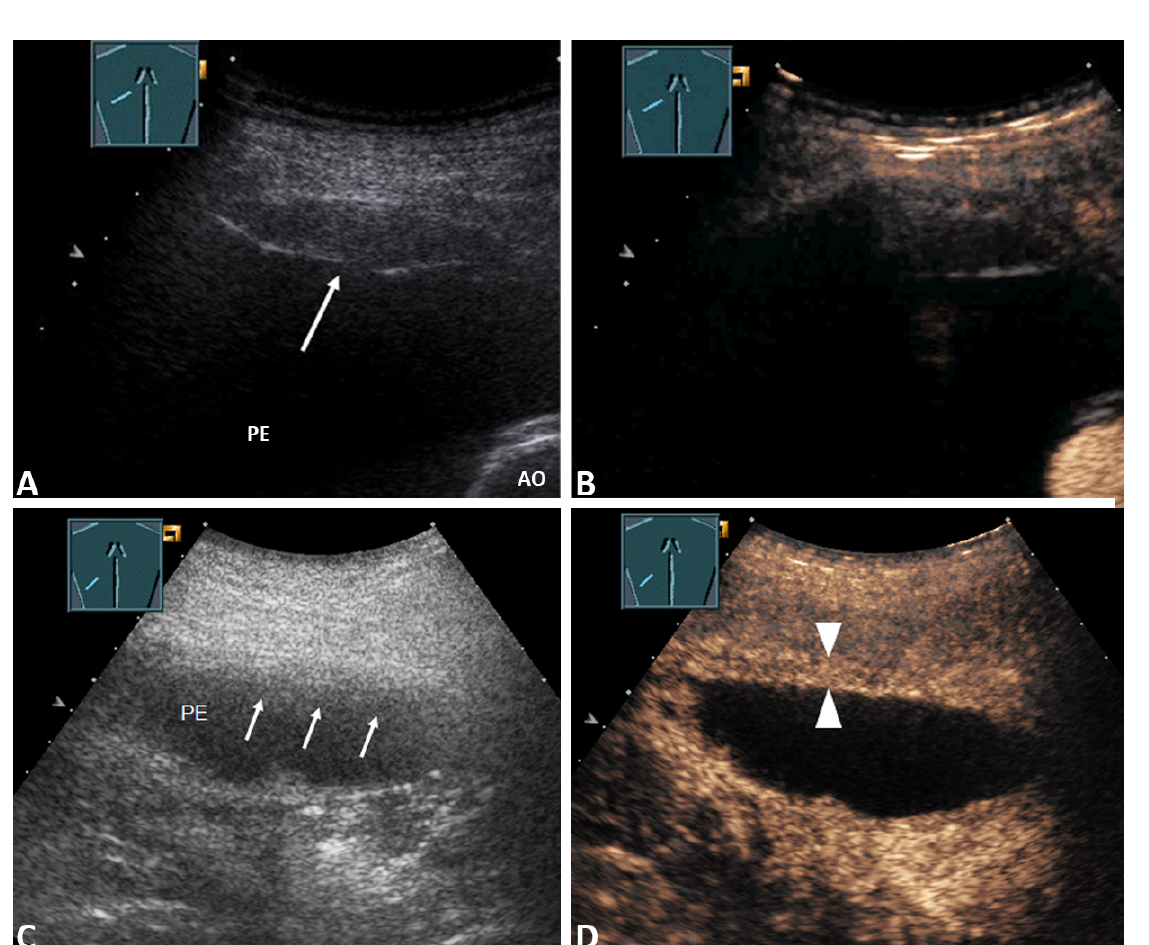
Figure 2. ( A ) 59-year-old patient with a right-sided PE. The effusion cytology was negative. B-TUS shows conspicuous nodular pleural thickening (arrow); ( B ) In the CEUS images, the nodular pleural thickening shows marked enhancement, such as in metastasis (stick). The final diagnosis was a malignant PE based on histologically confirmed pulmonary sarcoma. LI = Liver. ( C ) 64-year-old patient with fever, dyspnea, and a right PE. Effusion cytology was negative. B-US shows a septated effusion with a nodular formation on the diaphragm (arrow); ( D ) CEUS shows nodular pleural thickening with no enhancement, similar to fibrin bodies (sticks). The final diagnosis was a benign The values are indicated as number (%). A p -value < 0.05 was defined as significant. *: Fisher’s exact test. parapneumonic PE. LI = Liver.